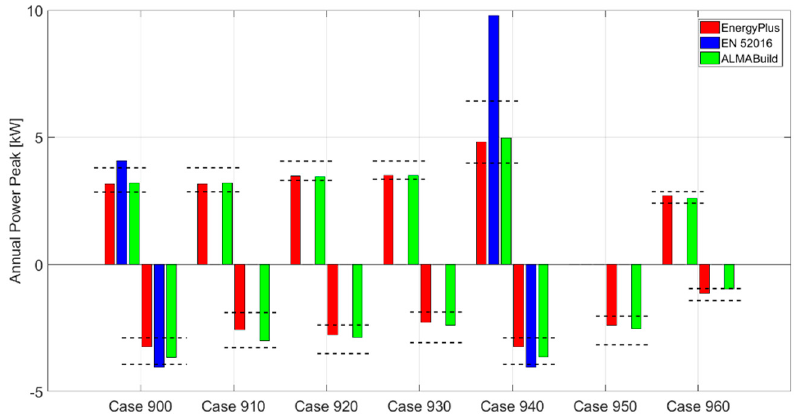
Figure 11. Comparison of the annual power peak (kW) predicted by EnergyPlus, the Standard EN 52016 and ALMABuild for heavyweight BESTEST buildings.